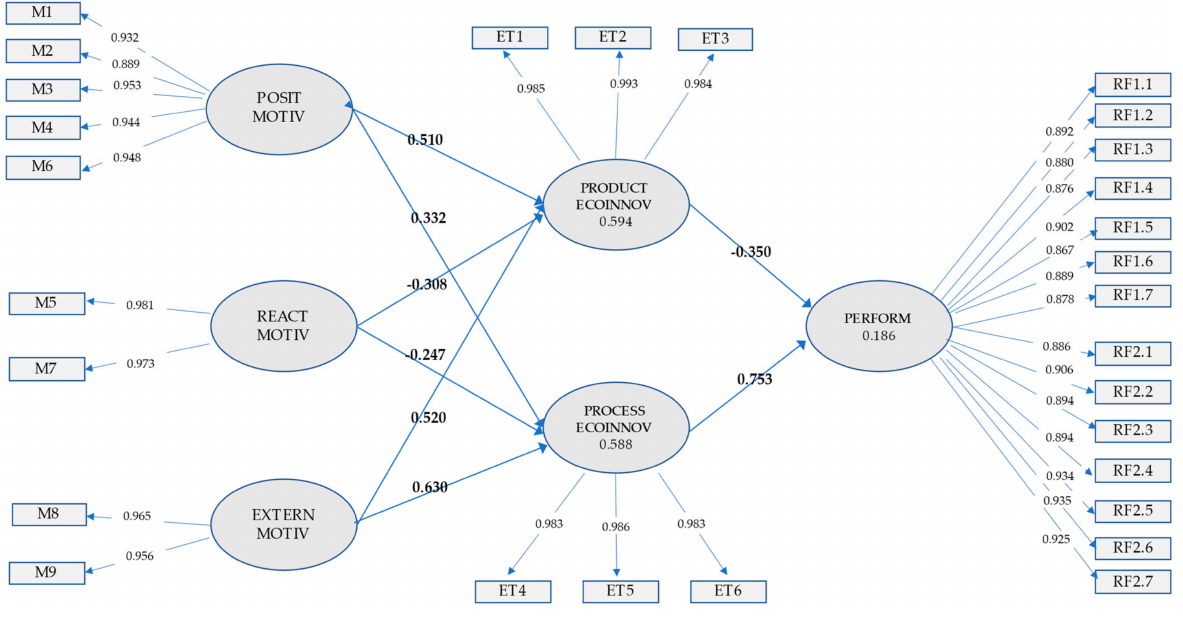
Figure 3. Estimated